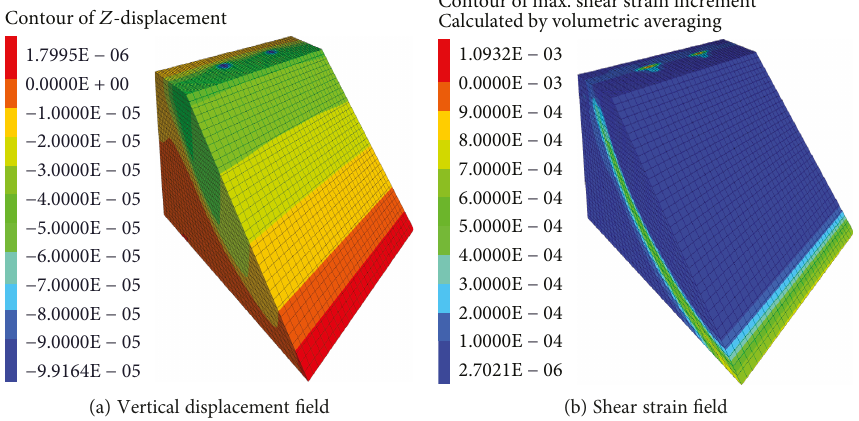
Figure 20: Vertical displacement fi eld and shear strain fi eld after loading of 20kg.